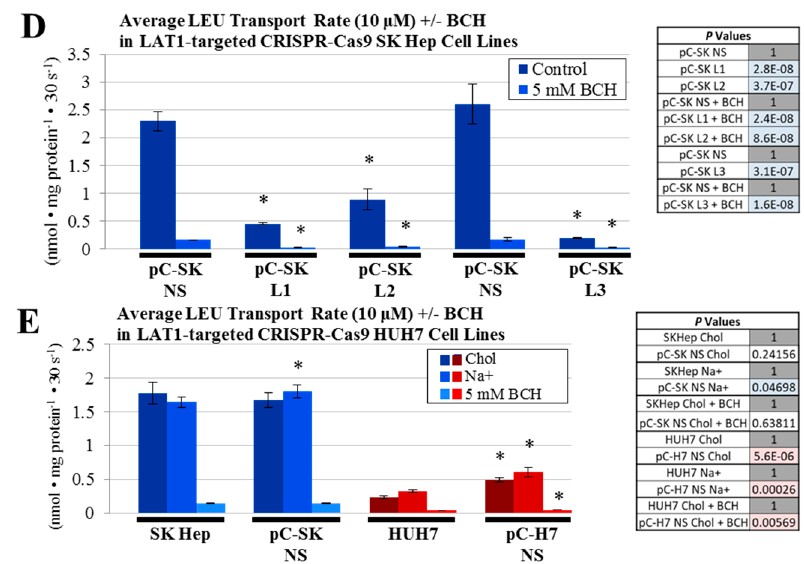
Figure 4. Na + -dependent glutamine ( L -[ 3 H]Gln) and Na + -independent leucine ( L -[ 3 H]Leu) initial rate uptake in the presence of transport inhibitors CRISPR-Cas9 HUH7 and SK Hep cell lines. Transport of 10 µ M L -glutamine and 10 µ M L -leucine was measured as described in Materials and Methods. Glutamine uptake mixes contained either MeAIB, a System A (SNAT1/SNAT2) inhibitor, or GPNA, a pan-specific glutamine transport inhibitor ( A , B ), and leucine uptake mixes contained BCH, a System L inhibitor ( C – E ). Leucine transport in control cell lines ( E ) was performed in Na + -containing and Na + -free (choline) buffers, as in Figure 3, while C and D were performed in Na + -free (choline) buffers. Data are the average of at least four separate determinations ± SD. Asterisks (*) denote values that are statistically significant with a p value < 0.050 compared to the respective control, as indicated in the adjacent tables.